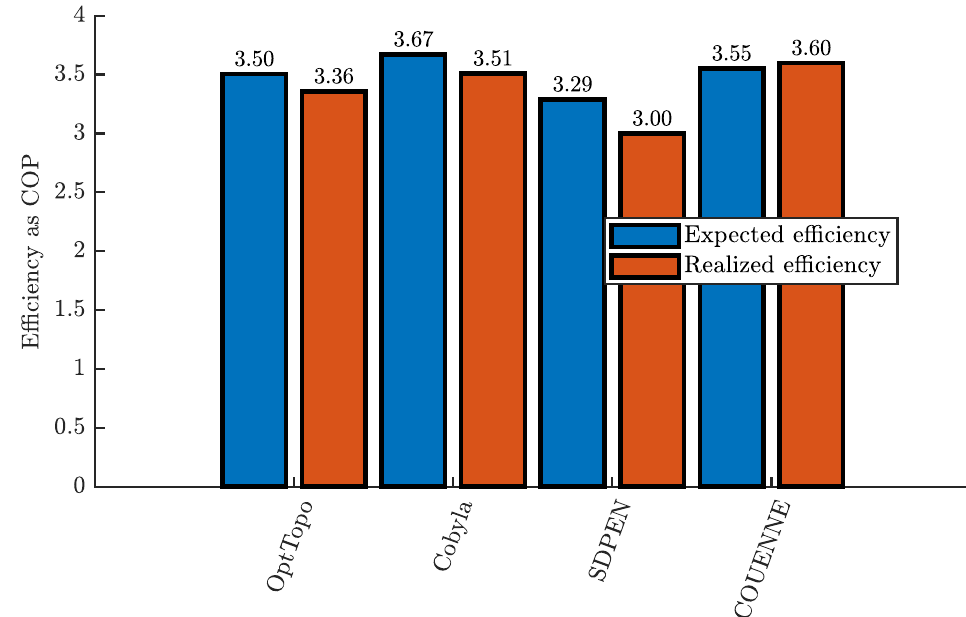
Figure 4. Efficiency of the optimizers in comparison: The blue bars illustrate the efficiency which is claimed by the optimization algorithm and the red bars give the actual achieved efficiency.